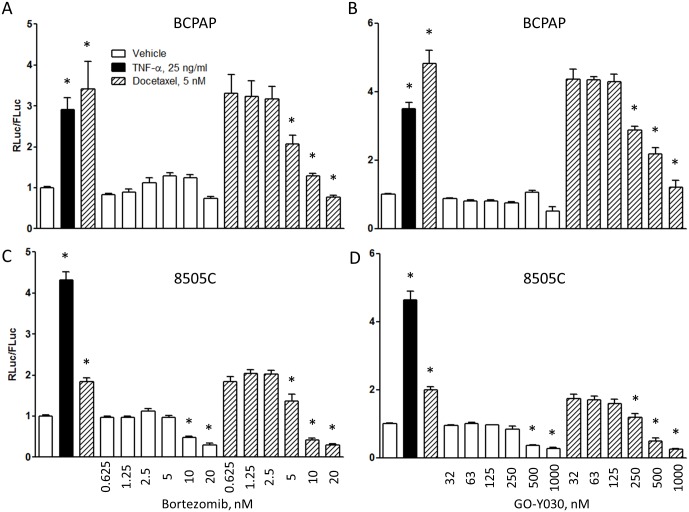
Docetaxel activates NF-κB signaling in thyroid cancer cell lines BCPAP (A,B) and 8505C (C,D).Proteasome inhibitor bortezomib and IKK complex inhibitor GO-Y030 counteract NF-κB activation by docetaxel. Cells were incubated with drugs for 48 h prior to reporter luciferase activity measurements. The differences between groups are highly significant (p<0.0001, one-way ANOVA). Asterisks indicate significant change (p<0.05, Newman-Keuls posttest) when compared to the corresponding control group (TNFα, docetaxel alone and bortezomib alone were compared to vehicle; docetaxel and bortezomib/GO-Y030 combinations were compared to the docetaxel only group).